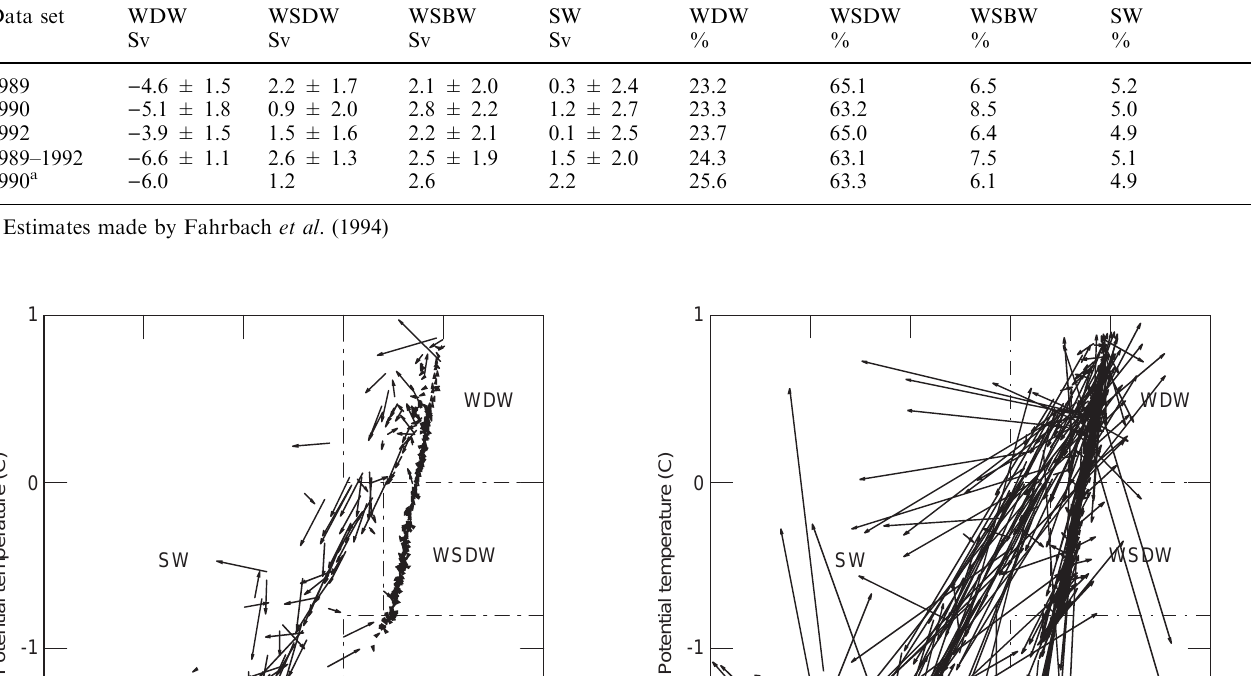
Table 4. Water mass transformation rates south of the section and areas of section plane occupied by water masses Data set WDW WSDW